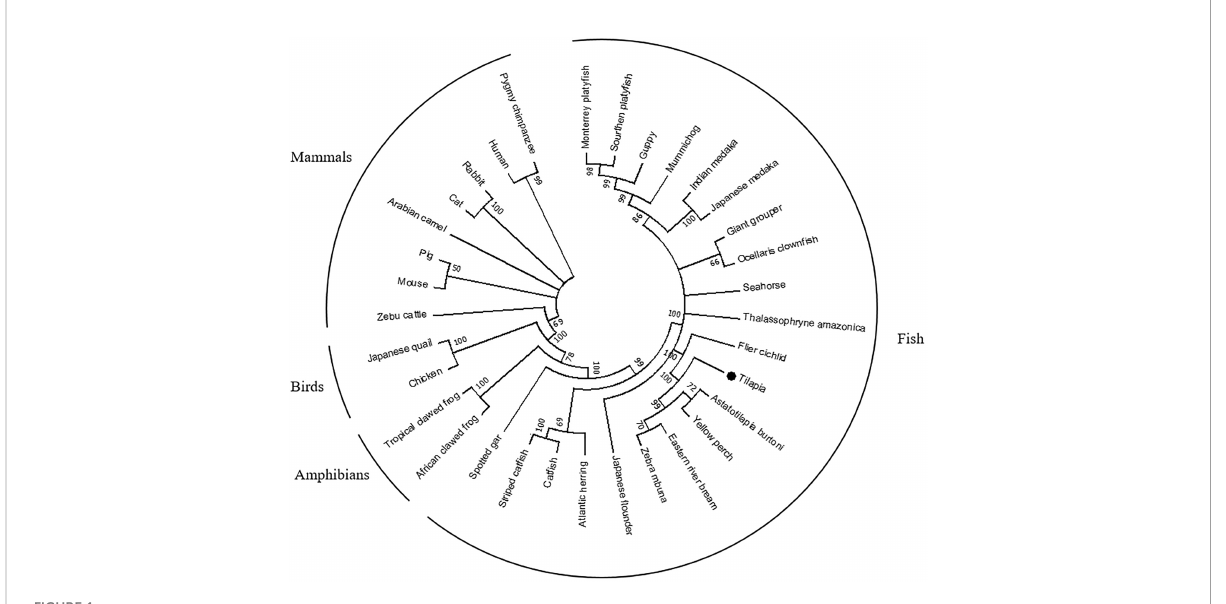
FIGURE 1 A phylogenetic tree of selected vertebrate SARM1 genes. The phylogenetic tree was constructed from multiple alignments of amino acid sequences (ClustalW), using the Maximum Likelihood method based on the JTT matrix-based model and supported by 10,000 bootstrap repetitions in the MEGA7 program. Data were analyzed by applying Neighbor-Join and BioNJ algorithms to a matrix of pairwise distances estimated using a JTT model and then selecting the topology using the superior log likelihood value. A black dot shows the Nile tilapia gene reported in this study. Accession numbers of the sequences used to construct the tree are listed in Supplementary Table